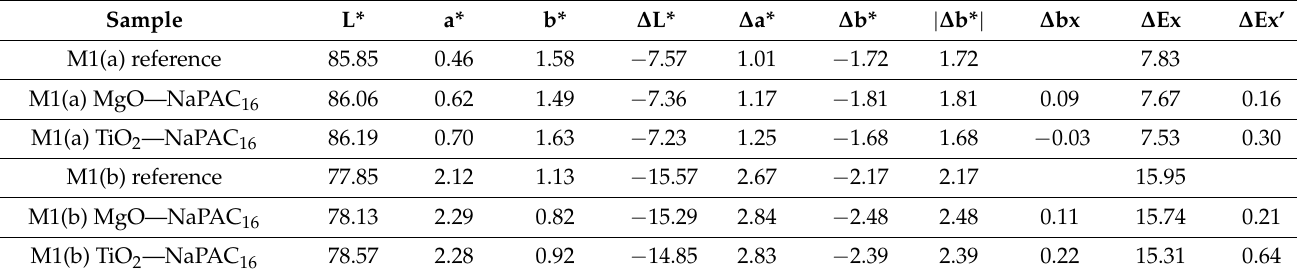
Table 9. Colorimetric parameters measured on the stone fragments before and after immersion in coating. Sample